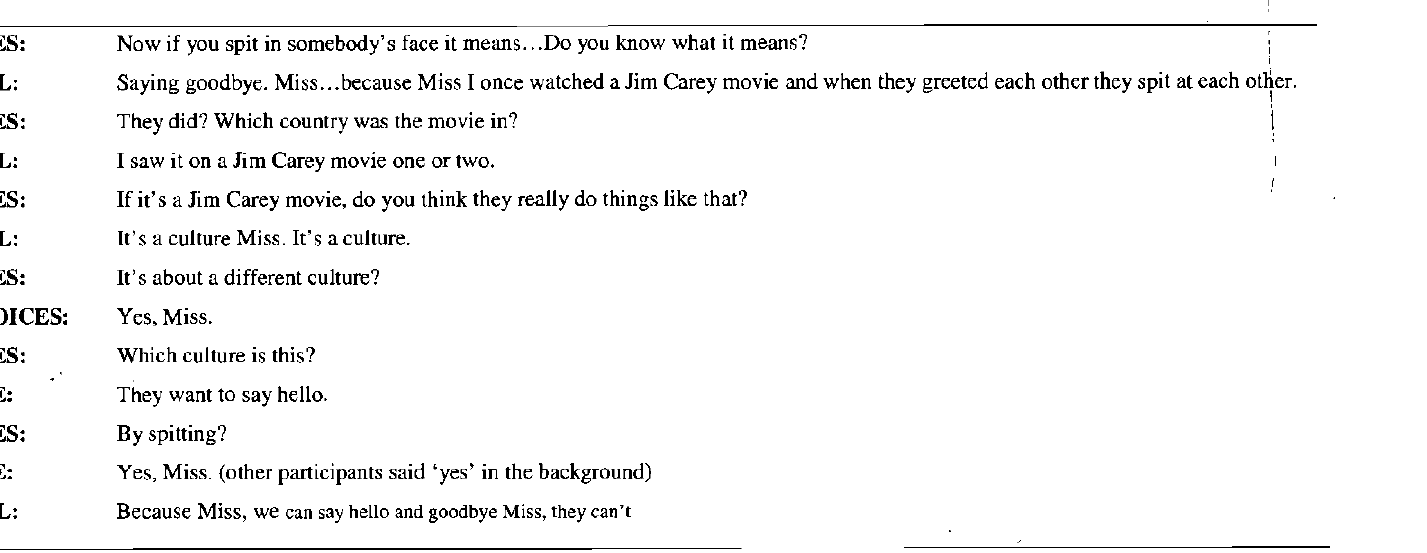
Table 1. The Influence of the Mass Media on Cultural